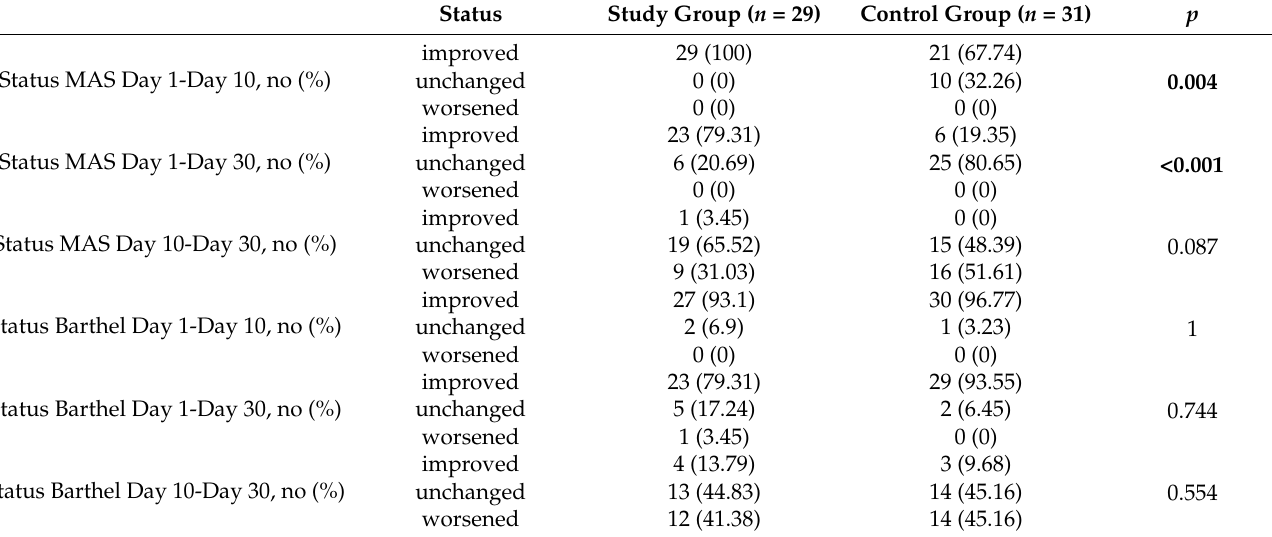
Table 3. Status analysis: improved, unchanged, or worsened between the moments of